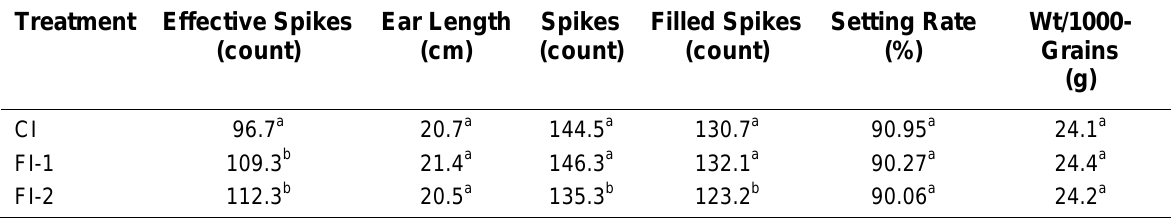
Grain Characteristics in the CI, FI-1, and FI-2 Treatments